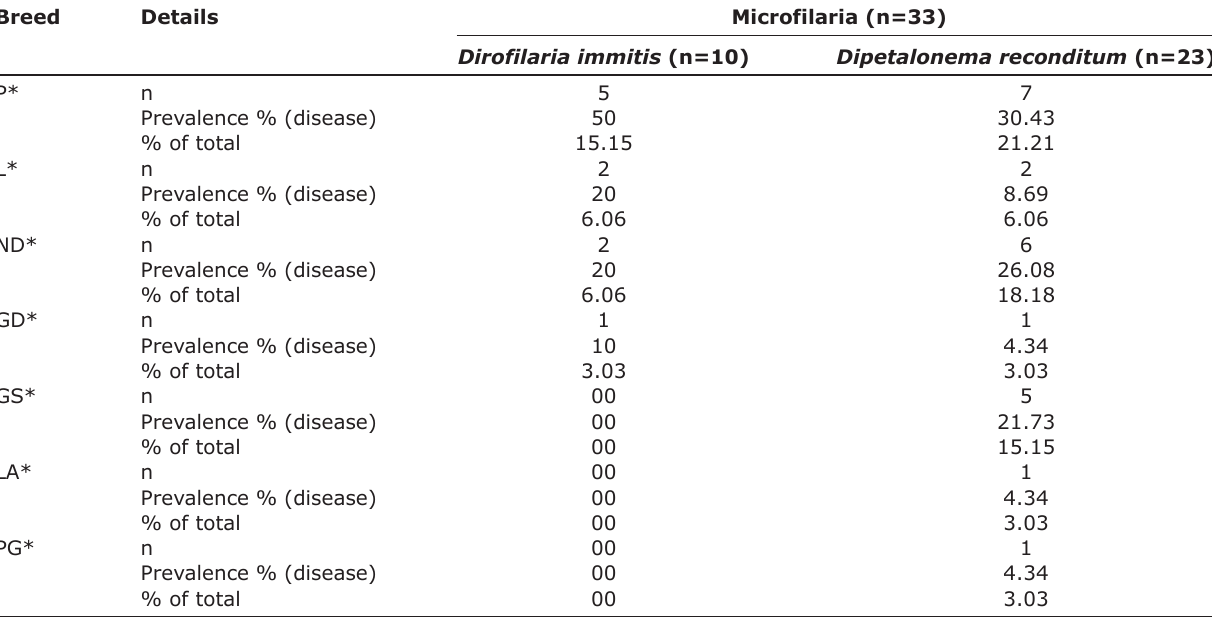
Table-2: Overall prevalence and distribution of microfilariae ( D. immitis and D. reconditum ) in different breeds of dogs from Gujarat state, India. Breed